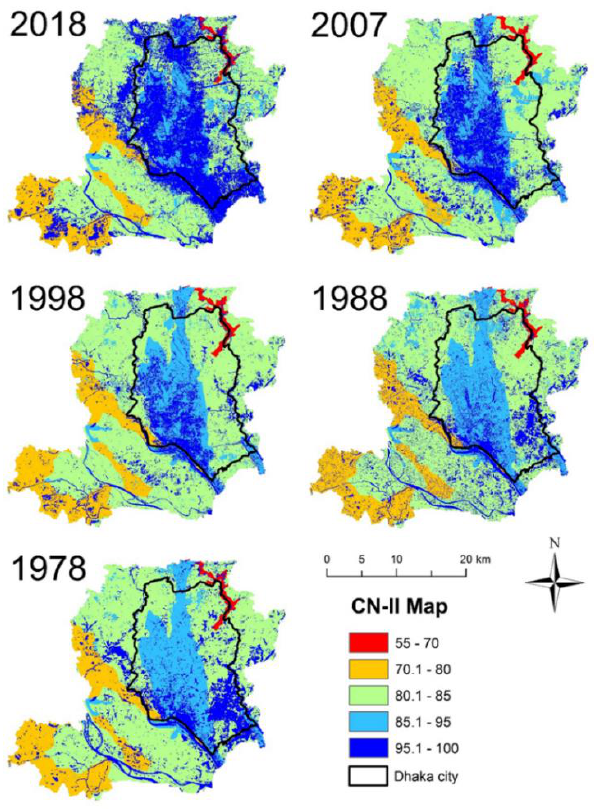
Figure 8. Surface runoff computed using NRCS-CN method for the catchment